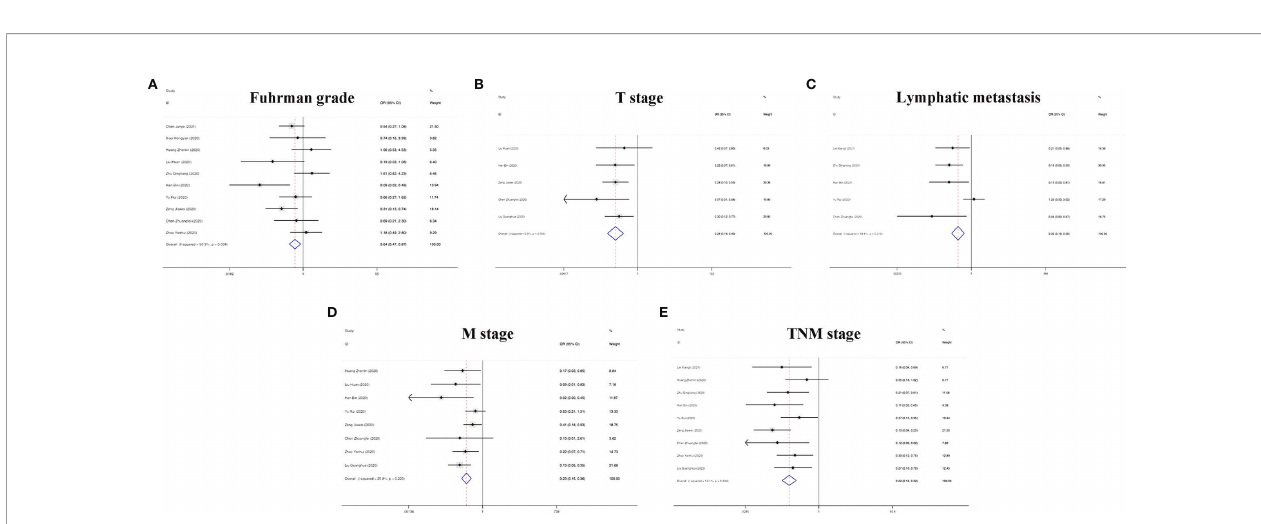
FIGURE 9 | Forest plots of the clinicopathological characteristics, (A) Fuhrman grade, (B) T stage, (C) lymphatic metastasis, (D) M stage, and (E) TNM stage for circRNAs in